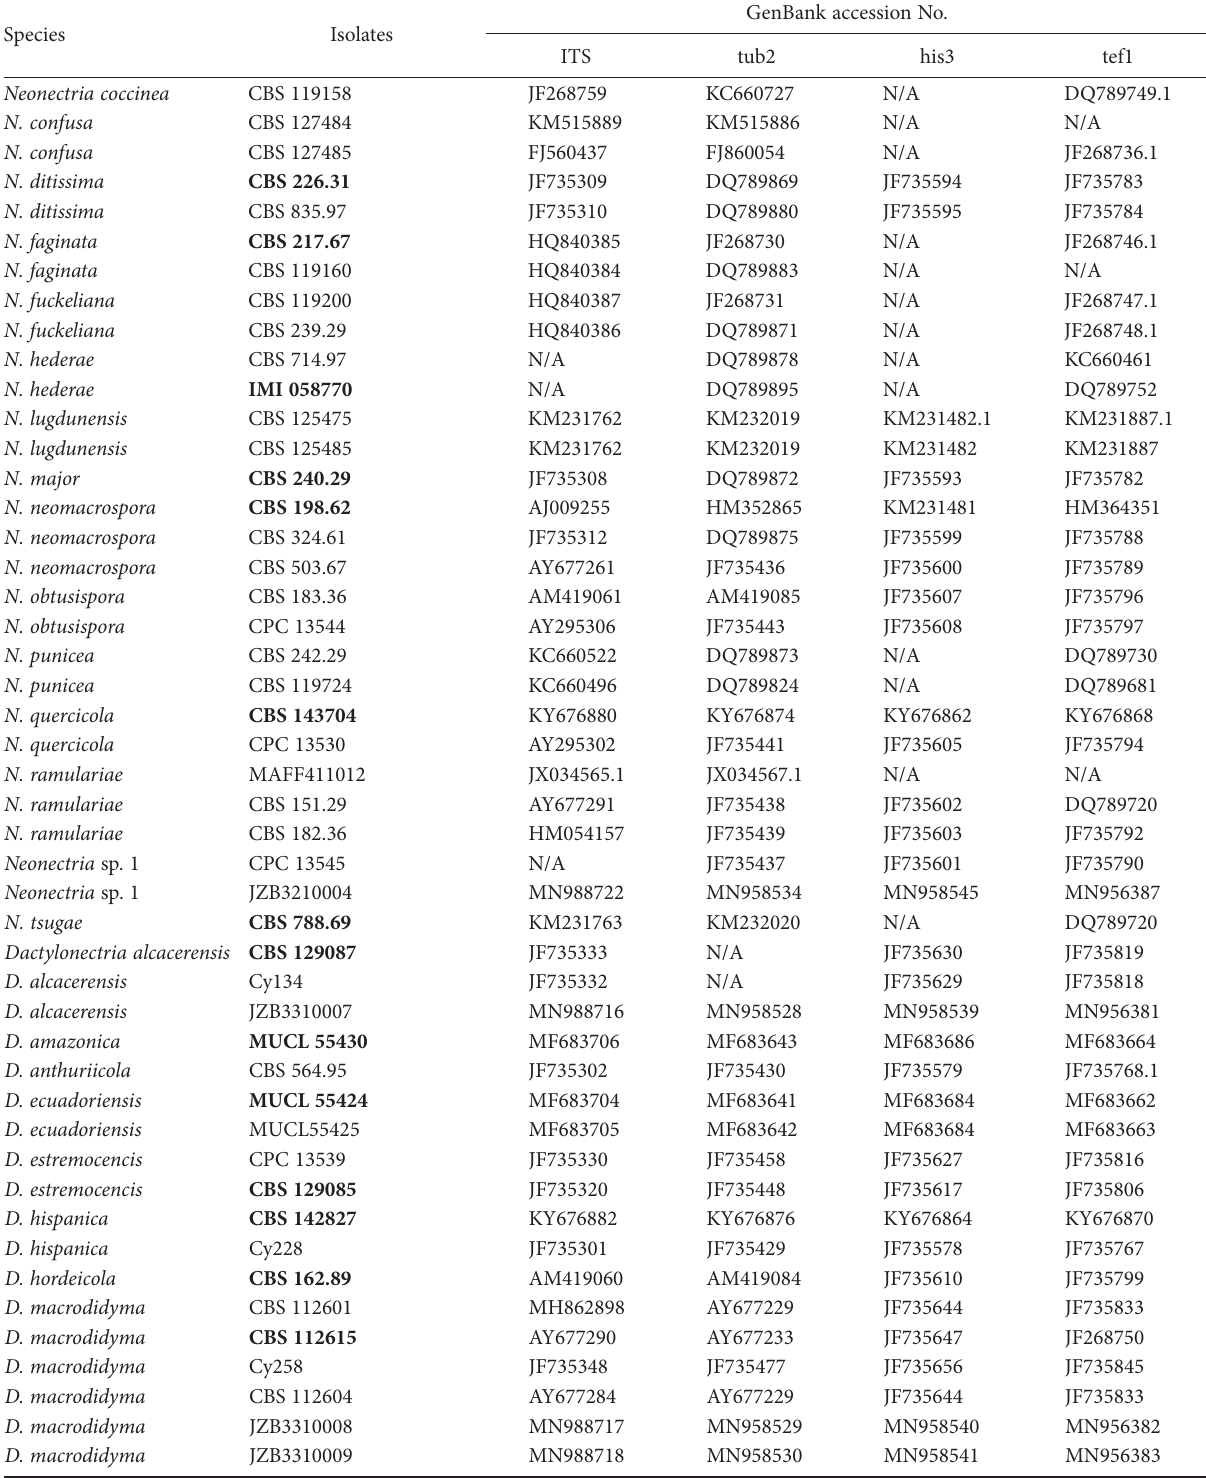
Table 2. Reference sequence data obtained from GenBank and isolate sequence data from the present study which were used for phyloge- netic